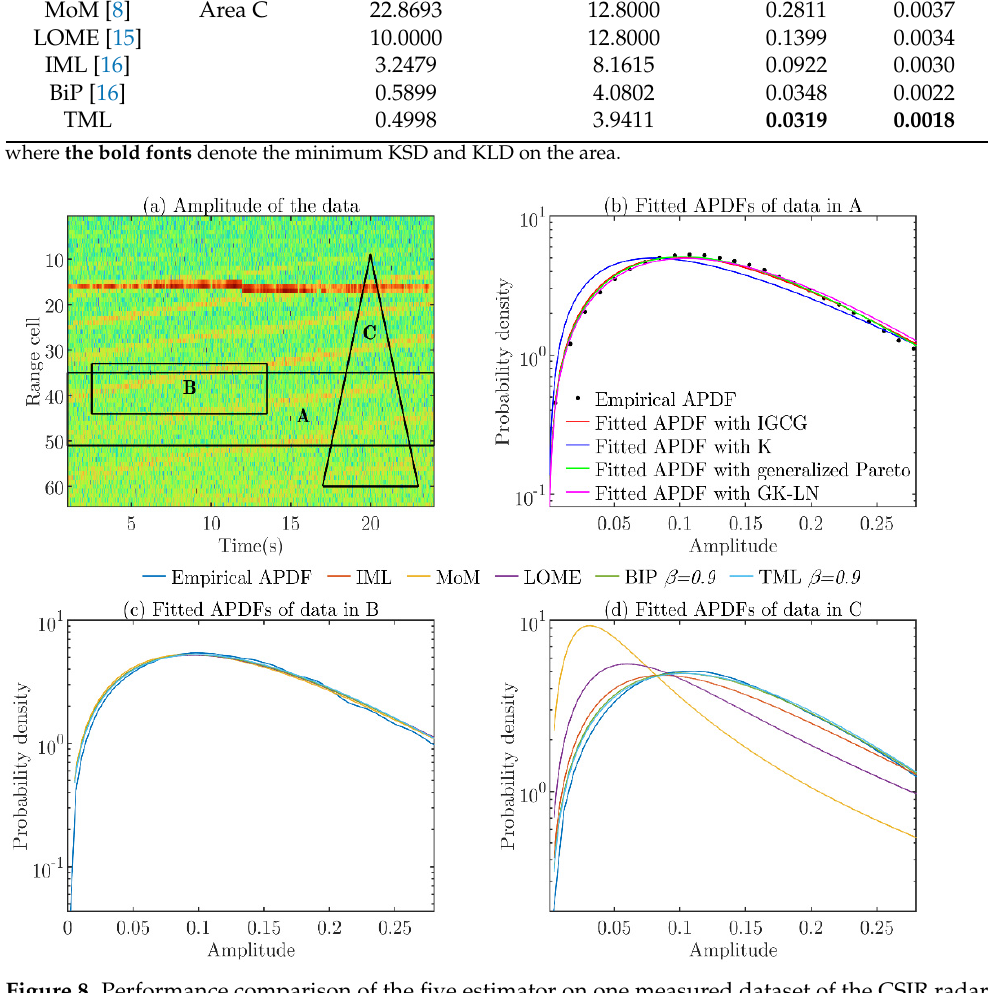
Figure 8. Performance comparison of the five estimator on one measured dataset of the CSIR